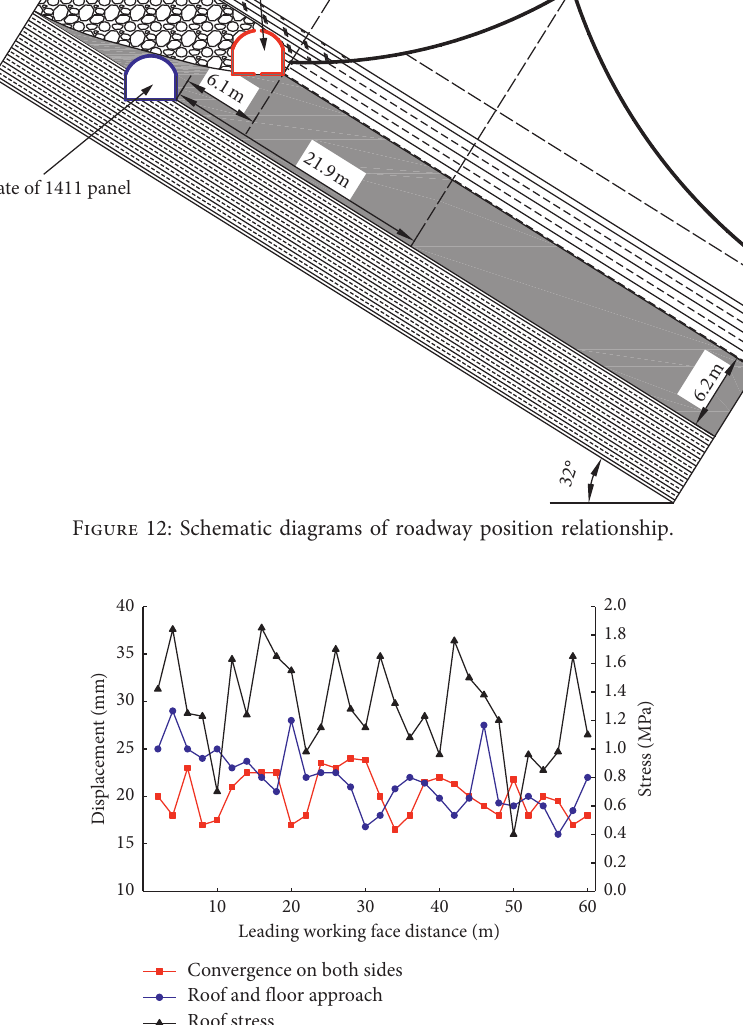
Figure 13: Displacement and roof pressure of the tail gate of panel